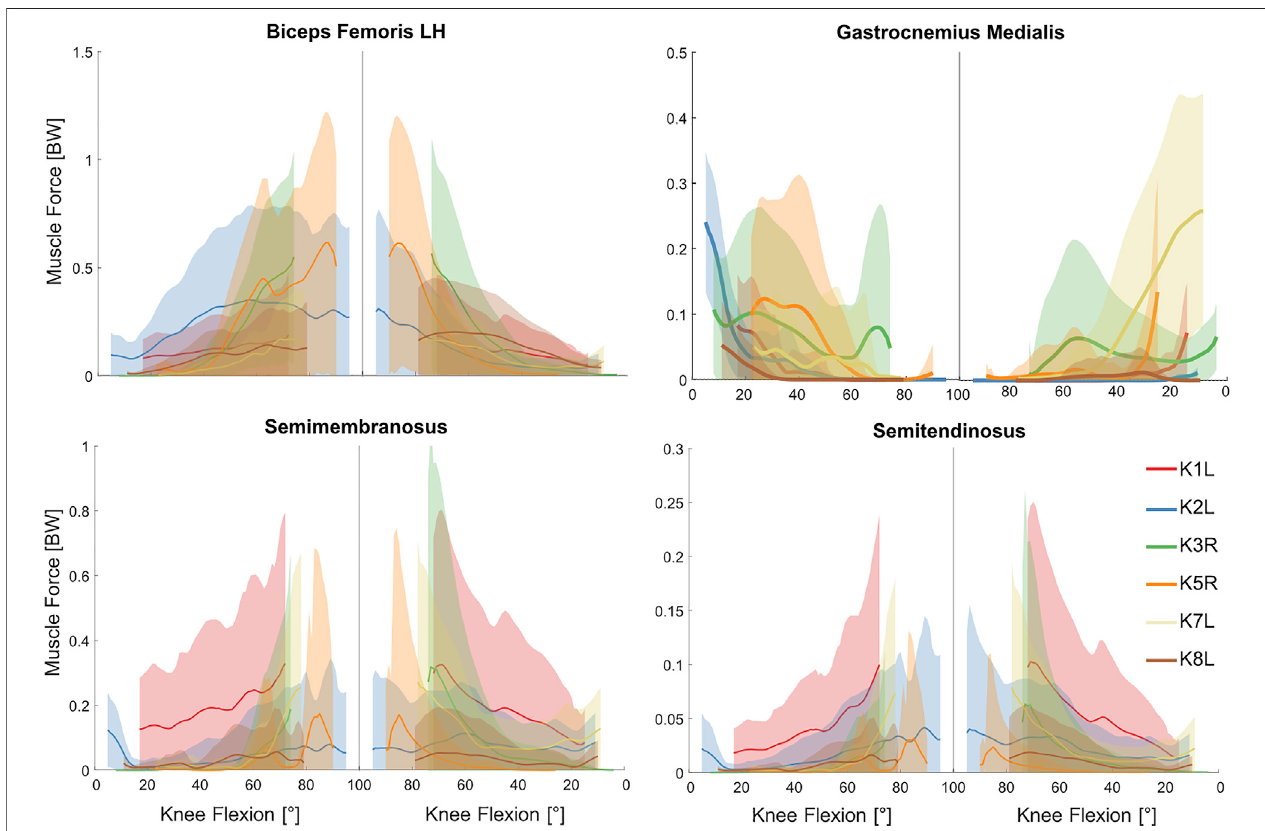
FIGURE 4 | Estimated forces in the knee fl exor muscles obtained from the baseline musculoskeletal models (solid lines) and 5th – 95th percentile range of the general Monte Carlo simulation outputs (shaded area) for the studied squat trials.